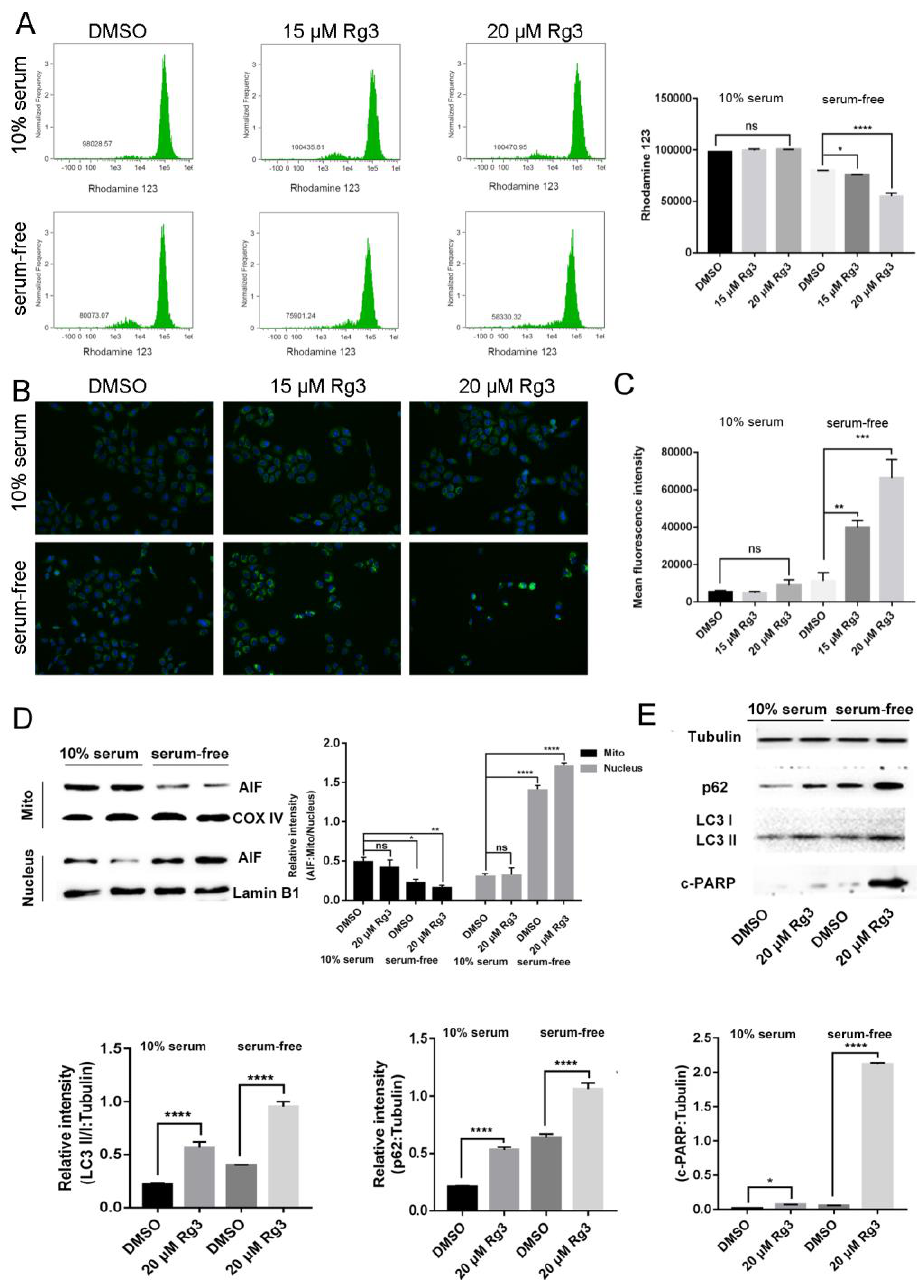
Figure 3. 20( S )-GRg3 induces apoptosis through the mitochondrion-AIF pathway. ( A ) Flow cytometry in combination with rhodamine 123 staining was performed in Hela cells. Hela cells were treated with DMSO or 20( S )-GRg3 in the presence or absence of serum. After 24 h, cells were harvested and subjected to rhodamine 123 staining followed by flow cytometry. ( B ) Immunofluorescence analysis of AIF (green) in Hela cells. Hela cells were treated with DMSO or 20( S )-GRg3 in the presence or absence serum. Then, the cells were fixed for immunofluorescence with an anti-AIF antibody. DAPI was used for nuclear staining. ( C ) Production of intracellular ROS detected by the H2DCFDA fluorescent probe. ( D ) Subcellular distribution of AIF in Hela cells detected by western blotting. HeLa cells were treated with DMSO or 20( S )-GRg3 in the presence or absence of serum for 24 h and then collected for subcellular fractionation. ( E ) HeLa cells were treated with DMSO or 20( S )-GRg3 in the presence or absence of serum and harvested after 24 h. The proteinexpression of p62, LC3 and c-PARP were evaluated by a western blotting assay. * p < 0.05, ** p < 0.01, *** p < 0.001, **** p < 0.0001, ns >